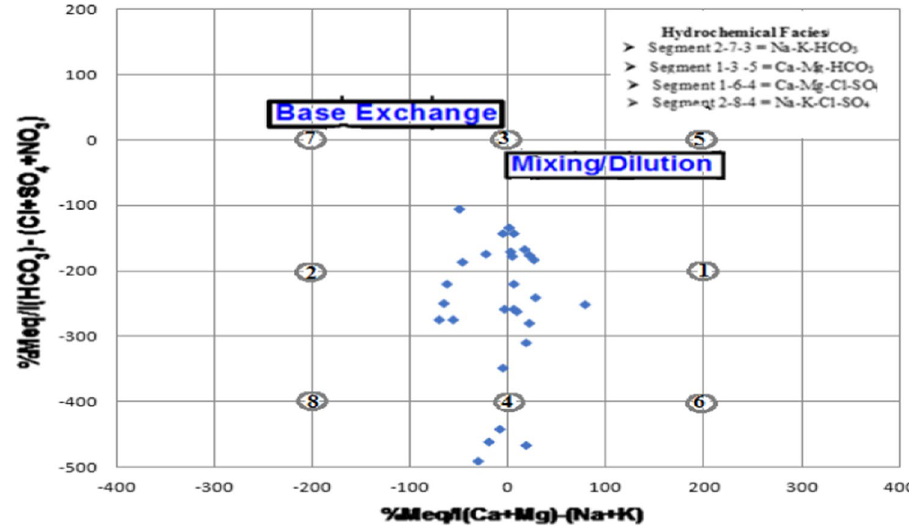
Fig. 5 Chadha plot of the groundwater